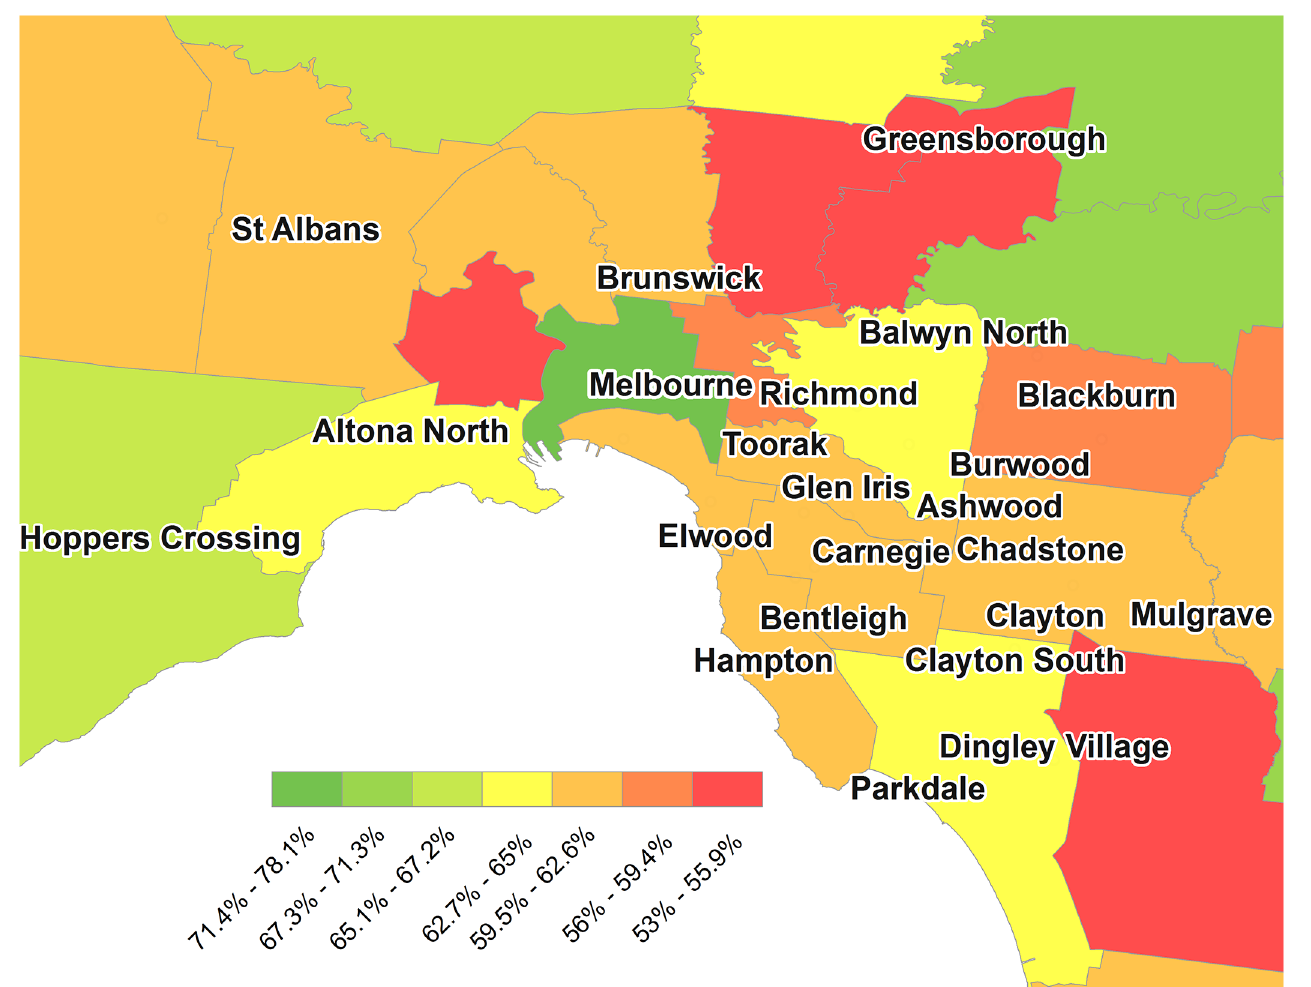
Fig 2. Prevalence of Bystander CPR in Melbourne and surrounding areas, 2008 – 2013 by Victorian Local Government Area.